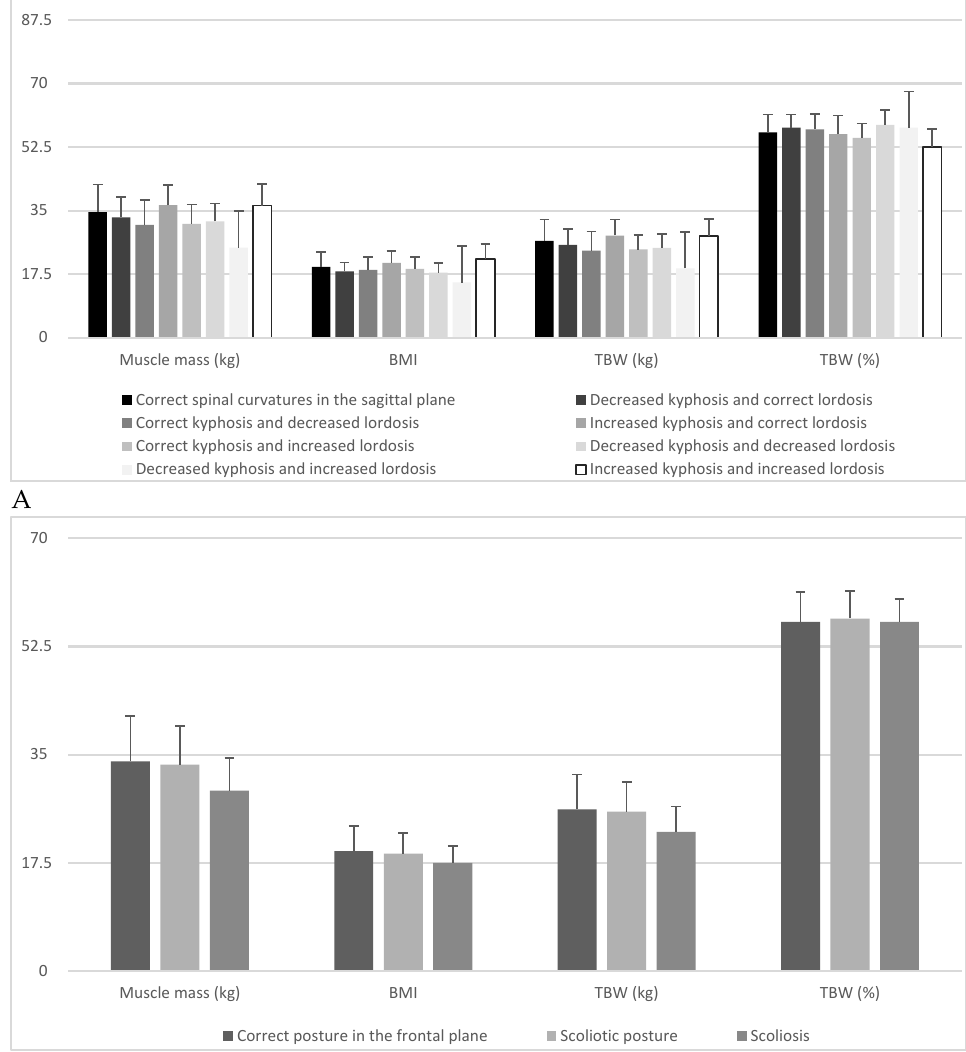
Figure 3. Muscle mass, body mass index, total body water and: sagittal spine types ( A ) and correct posture in the frontal plane, scoliotic posture and scoliosis ( B